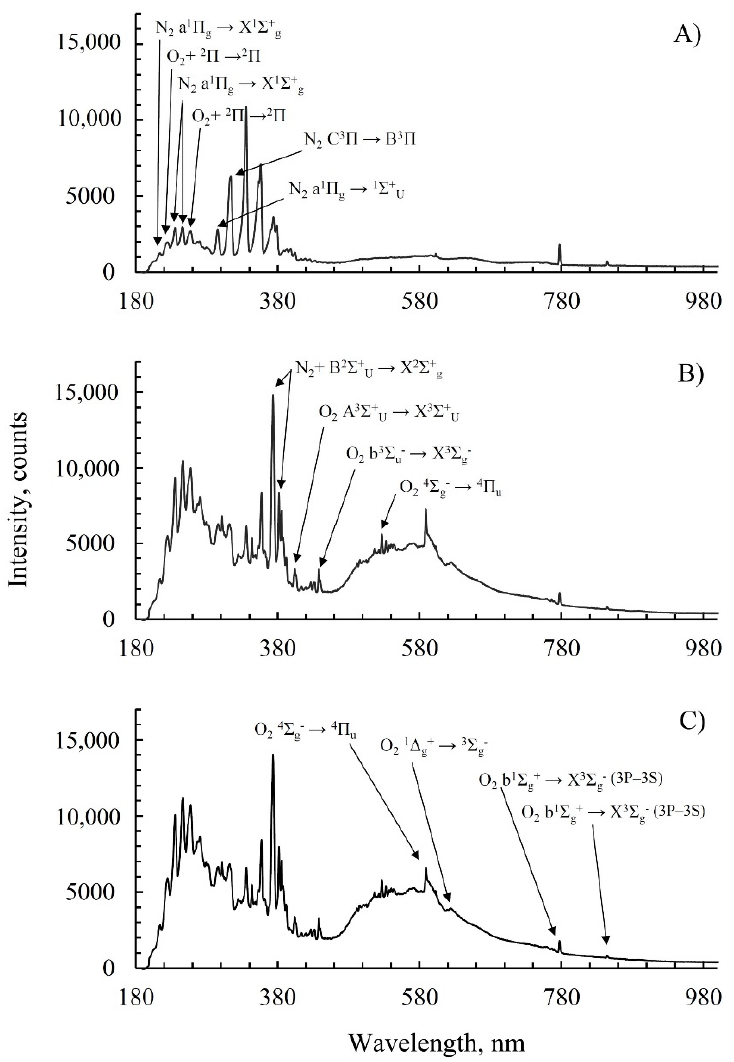
Figure 1. Emission spectrometry of air under different frequencies with the stable voltage U = 8300 V: ( A ) F = 60 kHz; ( B ) F = 180 kHz; (C) F = 220 kHz.